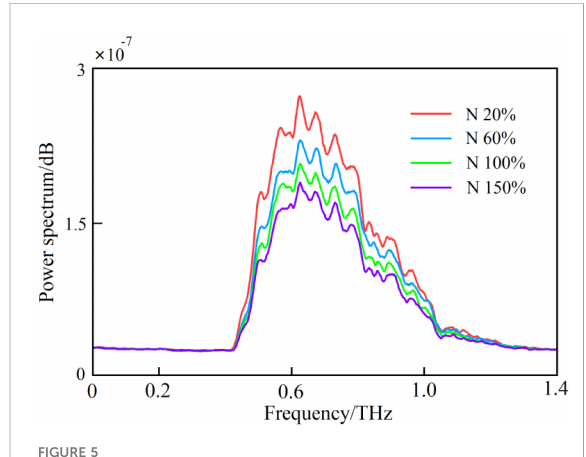
FIGURE 5 The THz frequency-domain spectra of leaf samples with different nitrogen